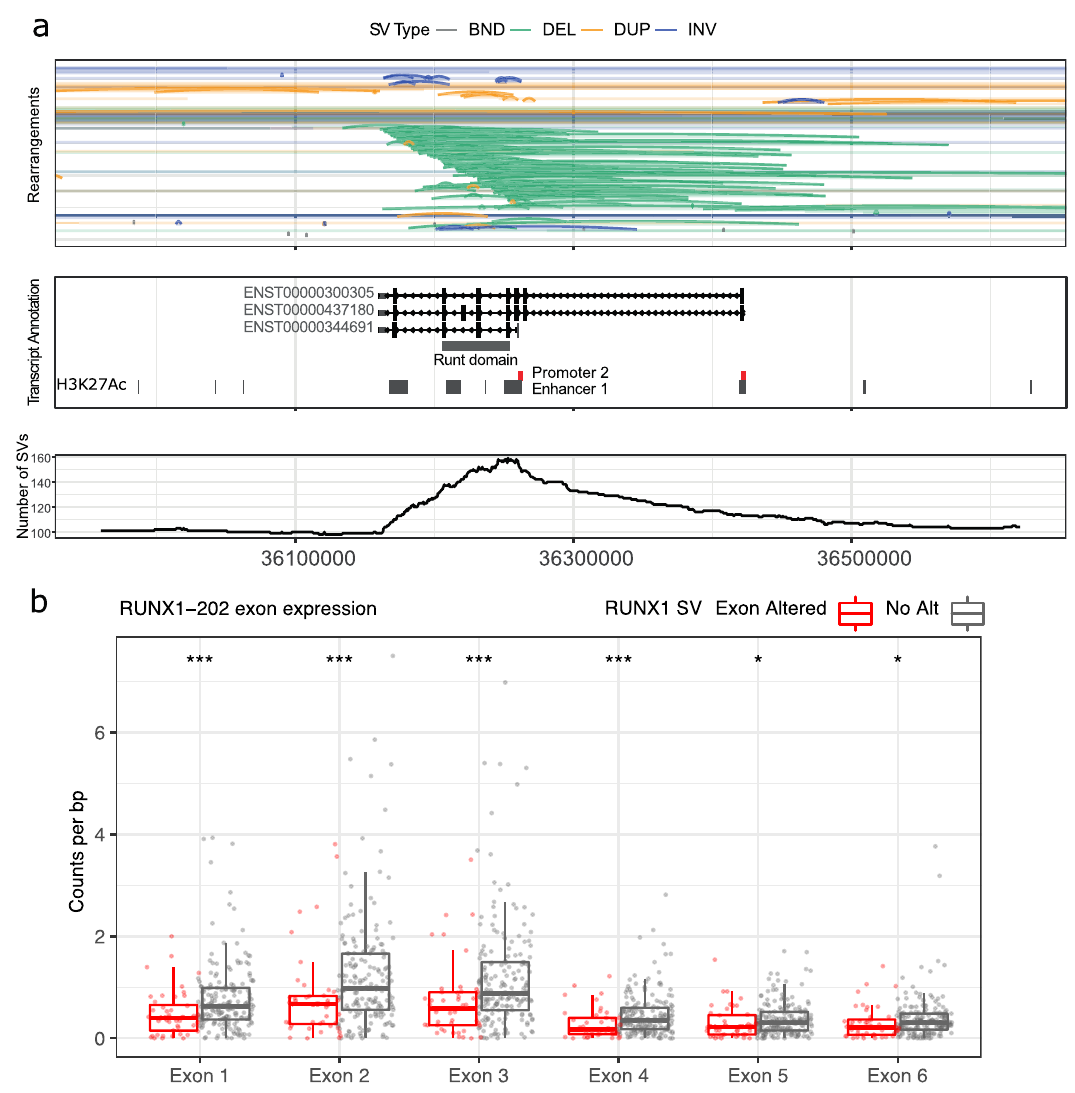
Fig. 5 Deletions and duplications in RUNX1 affecting RUNT domain exons. a Genomic regions with SVs at the RUNX1 locus (arcs) with cumulative numbers of SV intervals at each position (bottom). RUNX1 is transcribed from the negative strand. RUNT domain and enhancers, from H3K27Ac data, in grey, and promoters in red. b Exon expression of RUNX1-202 (ENST00000344691) for with tumours with alterations in RUNX1 (red) and no alterations (grey). Read counts were normalized to length of exons. *, *** denotes p ≤ 0.05 and p ≤ 0.001 respectively. Gene structure for RUNX1-202 shown as it was determined to be highest expressed transcript by GTEx and in the cohort of 214 tumours. No transcription from promoter 1 was